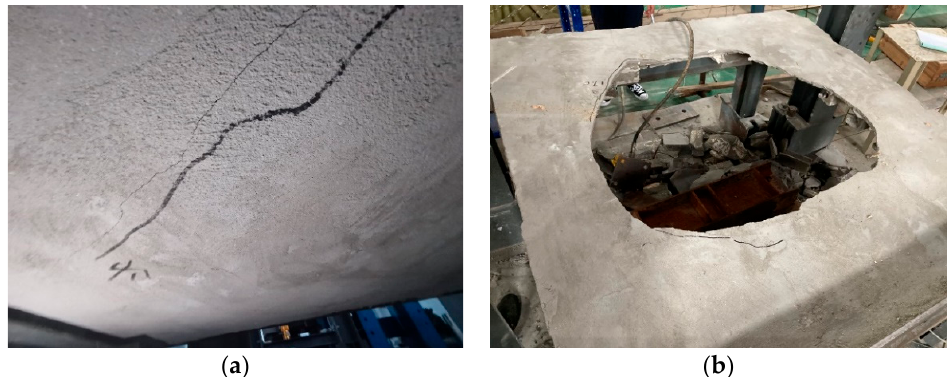
Figure 11. Brittle damage of specimen M2. ( a ) Cracks on the lower mortar surface; ( b ) damage area.